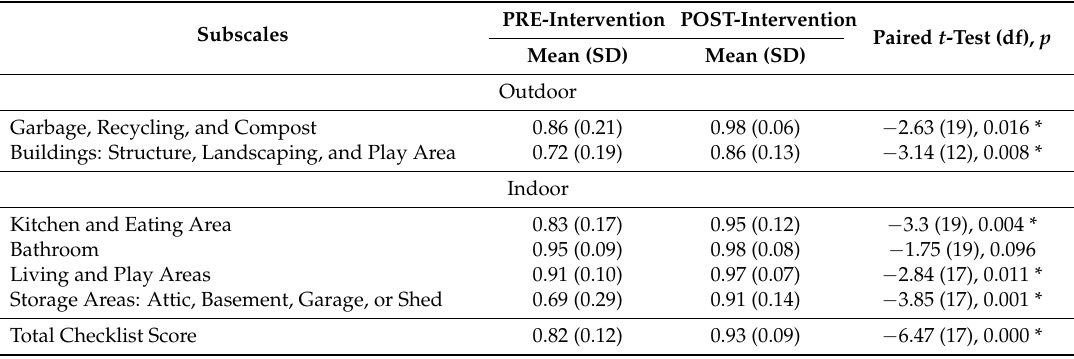
Table 5. IPM Checklist: Subscale and Total Mean by Pre- and Post-Intervention.